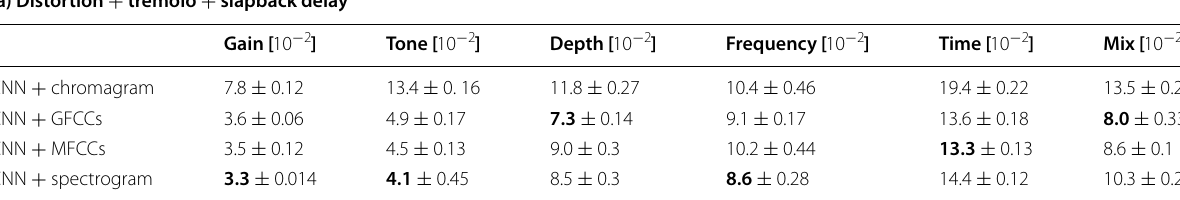
Table 8 95% confidence intervals of the mean absolute error of the CNN across the fivefold cross-validation of the parameter extraction and all volumes. Results are reported for all time-frequency representations and the combination of distortion, tremolo